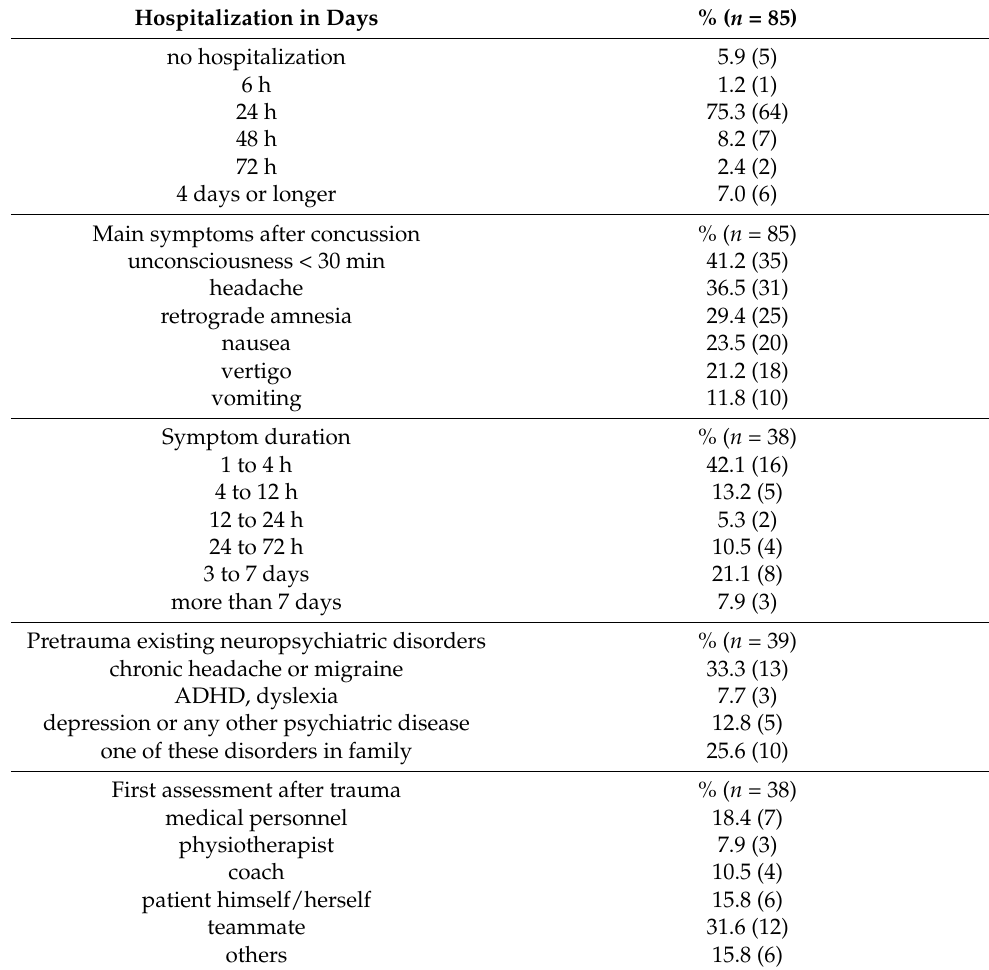
Table 2. Medical record information on sports-related concussion.